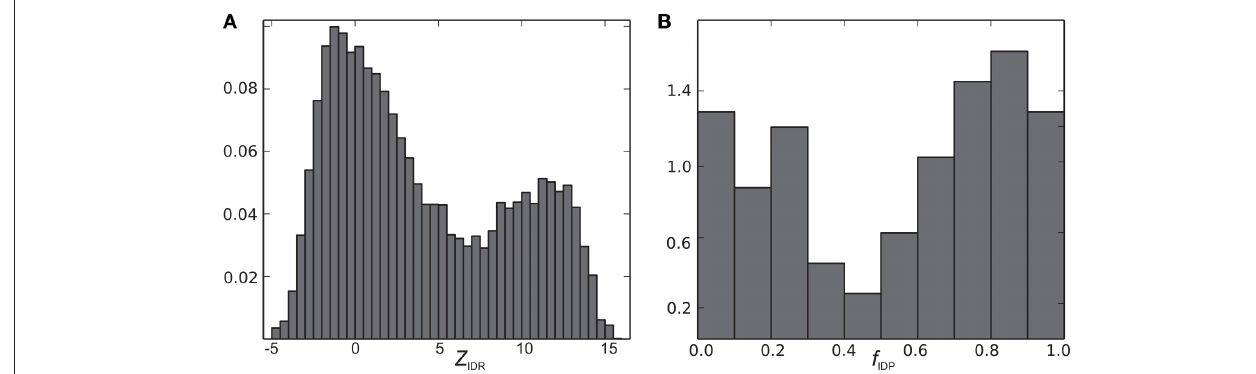
FIGURE 3 | Histograms of (A) Z IDR and (B) f IDP (normalized to a total area under the curve of 1.0).